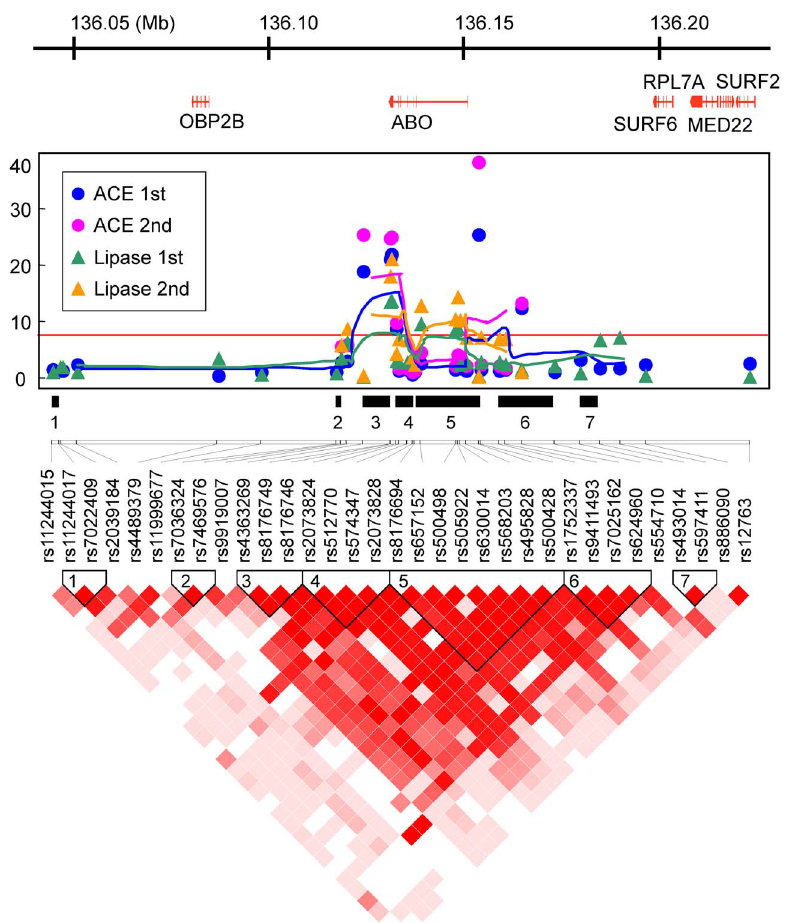
Figure 2. Gene map from RefSeq (upper panel), association pattern (middle), and LD structure (lower) by D 9 measure in the Takahata population, in the 186 kb region from 136,040,829 to 136,227,260 of 9q32, using the coordinate system of the human genomic DNA sequence (GRCh37/hg19). The association pattern is expressed by plots of 2 log(p-value) with lines connecting five-point moving averages for SNPs around the ABO and ACE1 loci in the Takahata (1st) and Yamagata (2nd) populations. The numbered black bars indicate LD blocks defined by a confidence-interval of D 9 measure that reflects those in the LD structure panel.